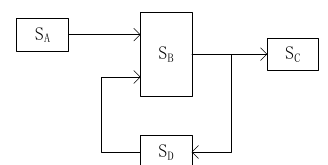
Figure 5. Cyclic execution-flows cause deadlock.